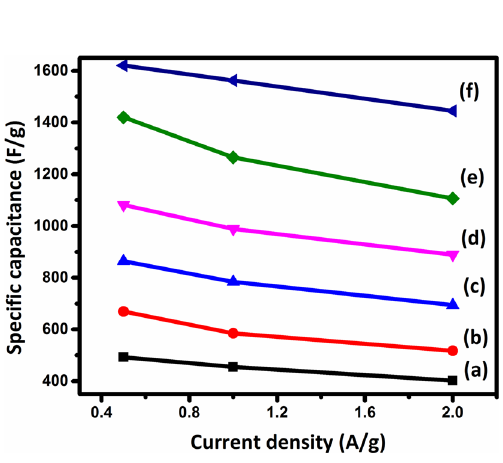
Figure 12. Specific capacitance versus current density for the electrodes constructed from the prepared Ni